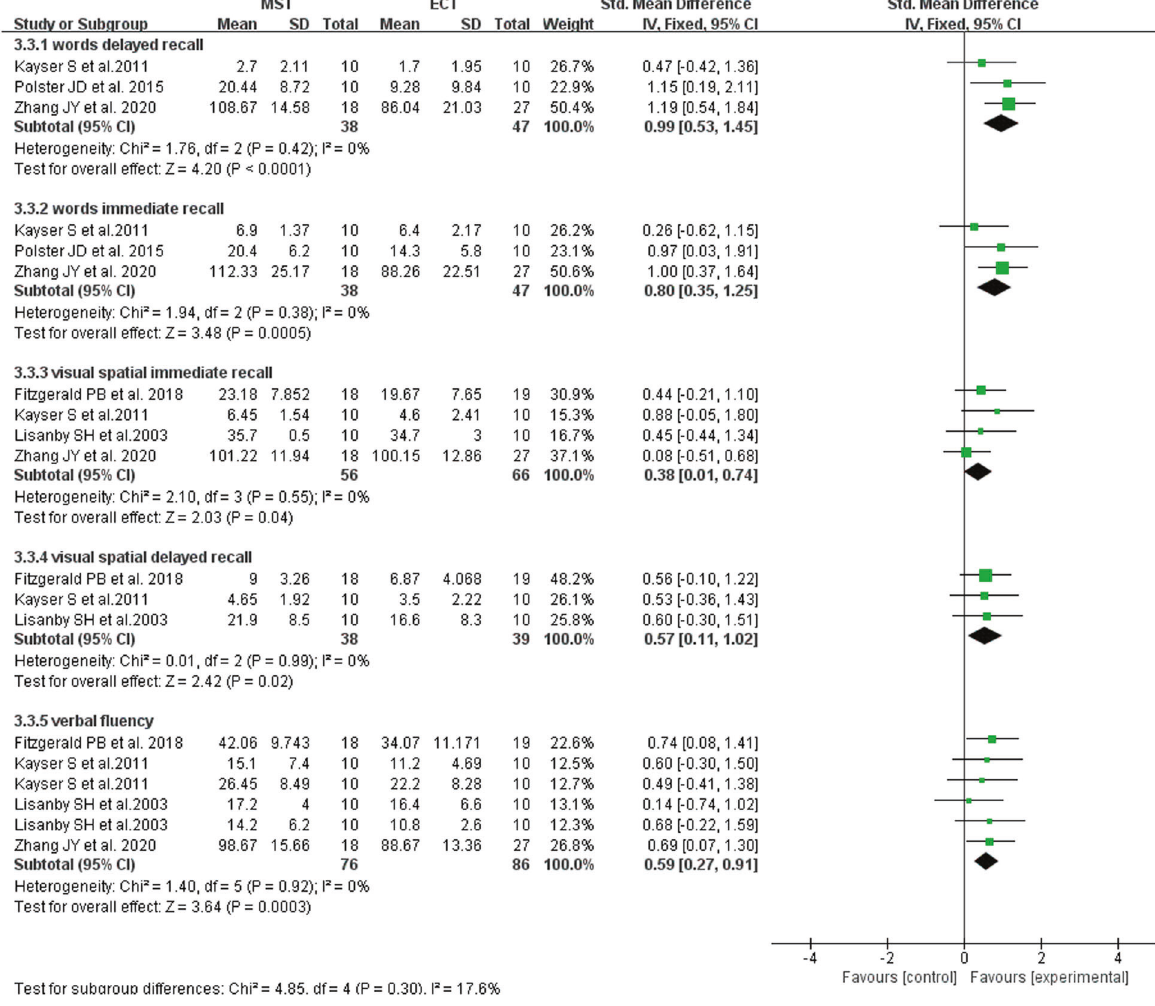
the antidepressant effect of MST from the perspective of neural mechanism [11, 36]. The above conclusion is slightly different from Fitzgerald [28], who reported two factors that might explain a lower remission rate of MST treatment. One is that the sample